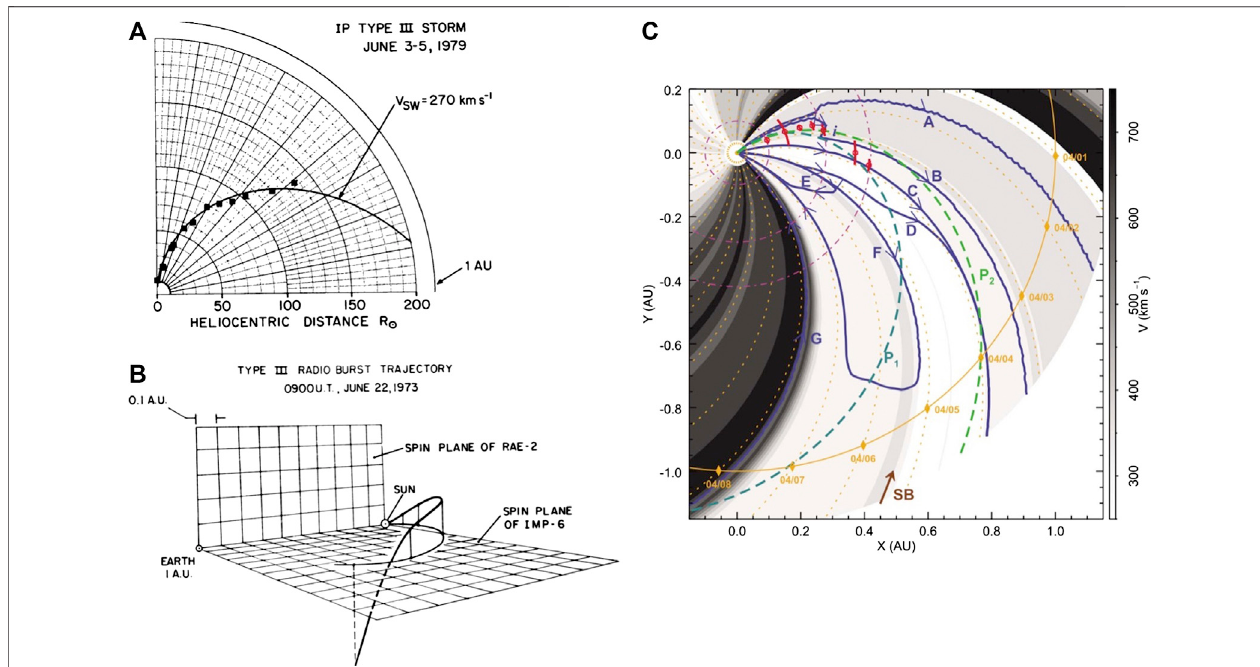
FIGURE 5 | Localization of interplanetary type III bursts; (A) Centroid positions of type III sources during a storm, with an overlaid Parker spiral fi eld line for a solar wind speed of 270 km s − 1 (Bougeret et al., 1984, ©ESO). (B) 3D magnetic fi eld line inferred from direction fi nding and a density model (Fitzenreiter et al., 1977, fi gure from https://ntrs.nasa.gov/citations/19770005004). (C) Type III locations (red arcs, from Reiner et al., 2009) compared with two Parker spiral fi eld lines ( P 1 , P 2 ) as proposed by Reiner et al. and an alternative 2D magnetic fi eld model (A) – (D) , (F) , from Li et al. (2016), ©AGU. Figures reproduced with permission.